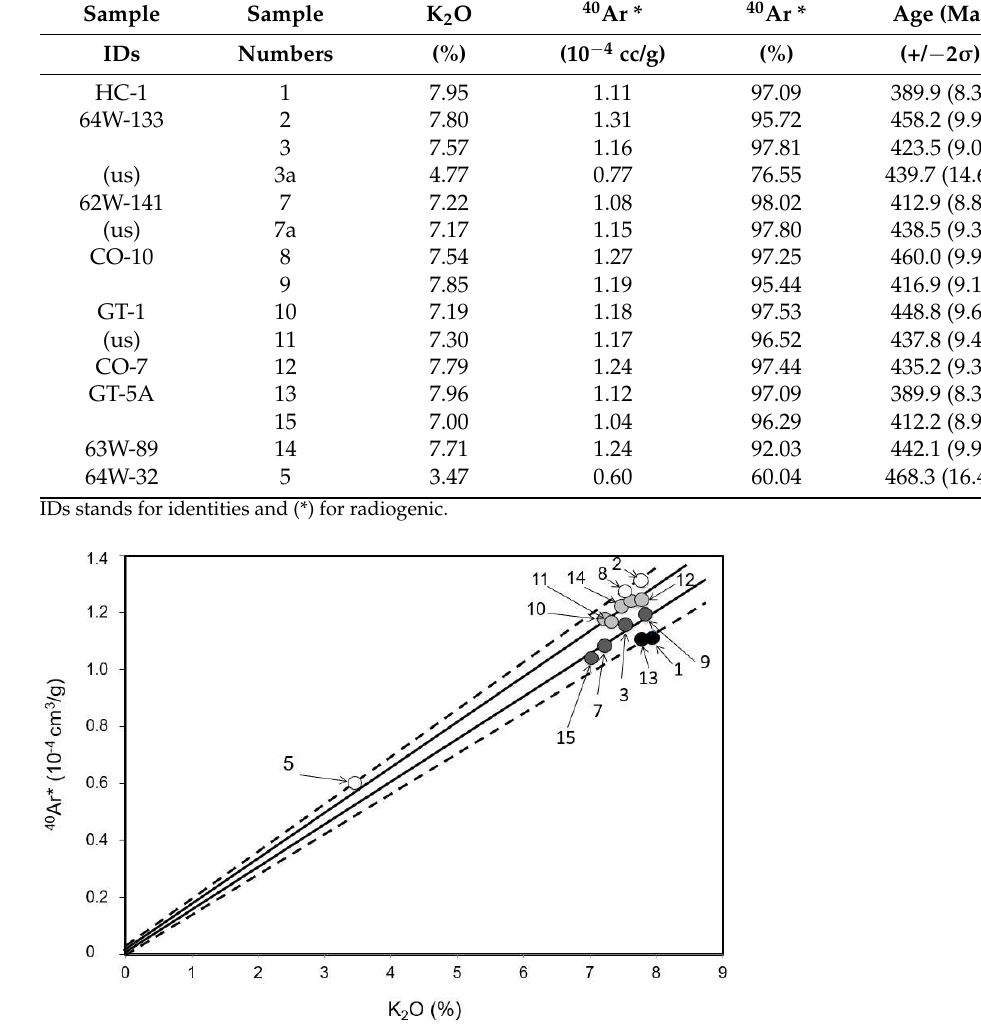
Figure 2. Harper [55] display of the K-Ar data from untreated glauconite-rich pellets.